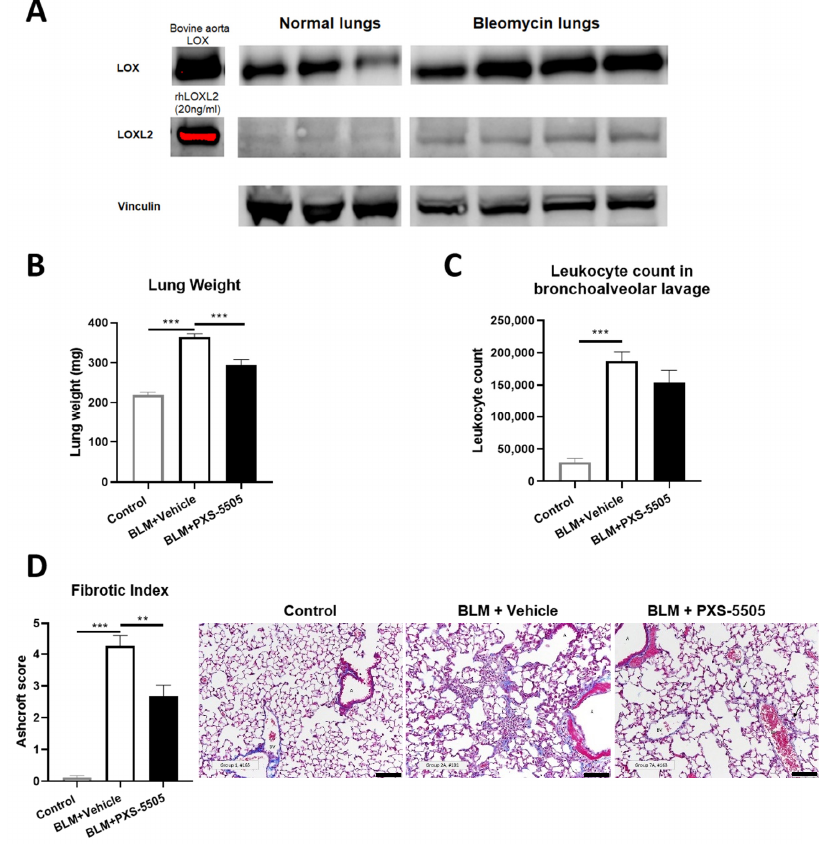
Figure 3. Effect of PXS-5505 treatment on bleomycin induced pulmonary fibrosis in mouse. ( A ) Western blot showing elevated protein expression of LOX and LOXL2 in bleomycin induced fibrotic mouse lungs. ( B ) Elevated gross lung weight in bleomycin treated animals was significantly lowered by PXS-5505 treatment. ( C ) Increased leukocyte count in bronchoalveolar lavage was deter- mined. The PXS-5505 treatment did not significantly change the level. ( D ) Bleomycin treated mice showed significant elevation in the levels of fibrosis that were ameliorated by PXS-5505 treatment. Lung tissue slices were stained with Masson’s trichrome to differentiate fibrotic tissue (blue) and fibrosis semi-quantified by the validated Ashcroft scoring system; A = airway, BV = blood vessel, scale bar = 100 µm (** p < 0.01, *** p < 0.001 between the indicated groups).